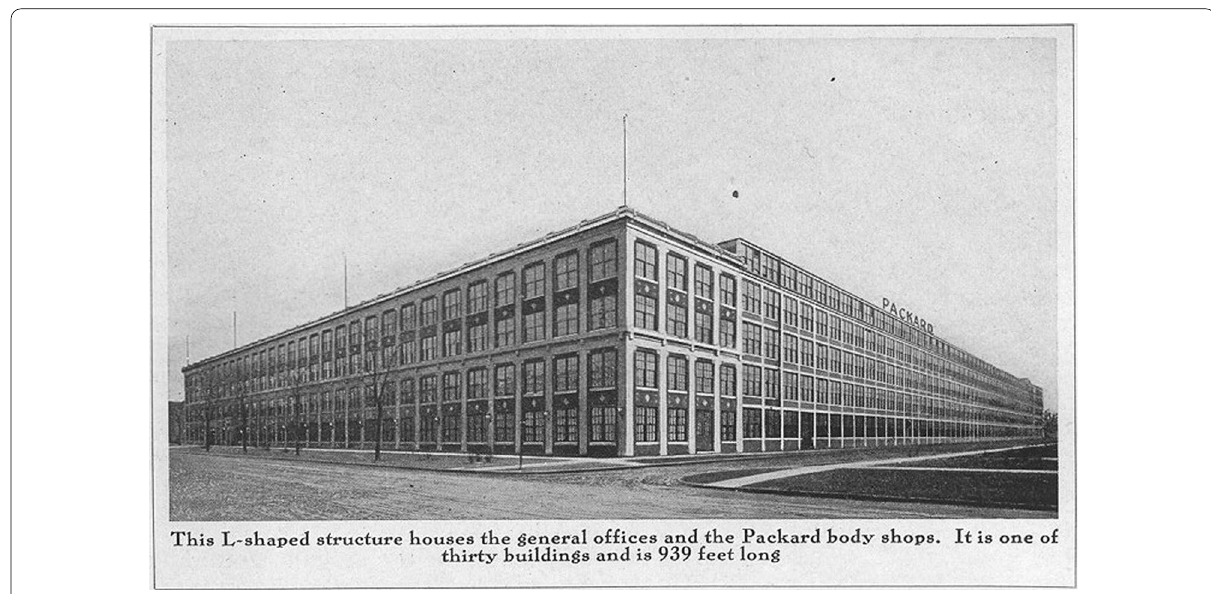
Fig. 2 Packard Automobile Plant, Detroit, Michigan. Architect: Albert Kahn (Photo by unknown